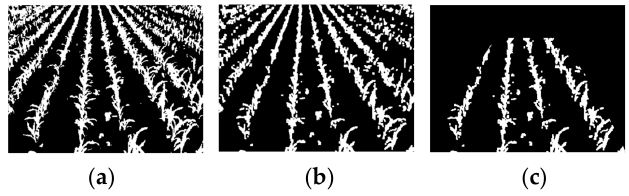
Figure 5. ( a ) Binary image; ( b ) Morphology image; ( c ) ROI image.